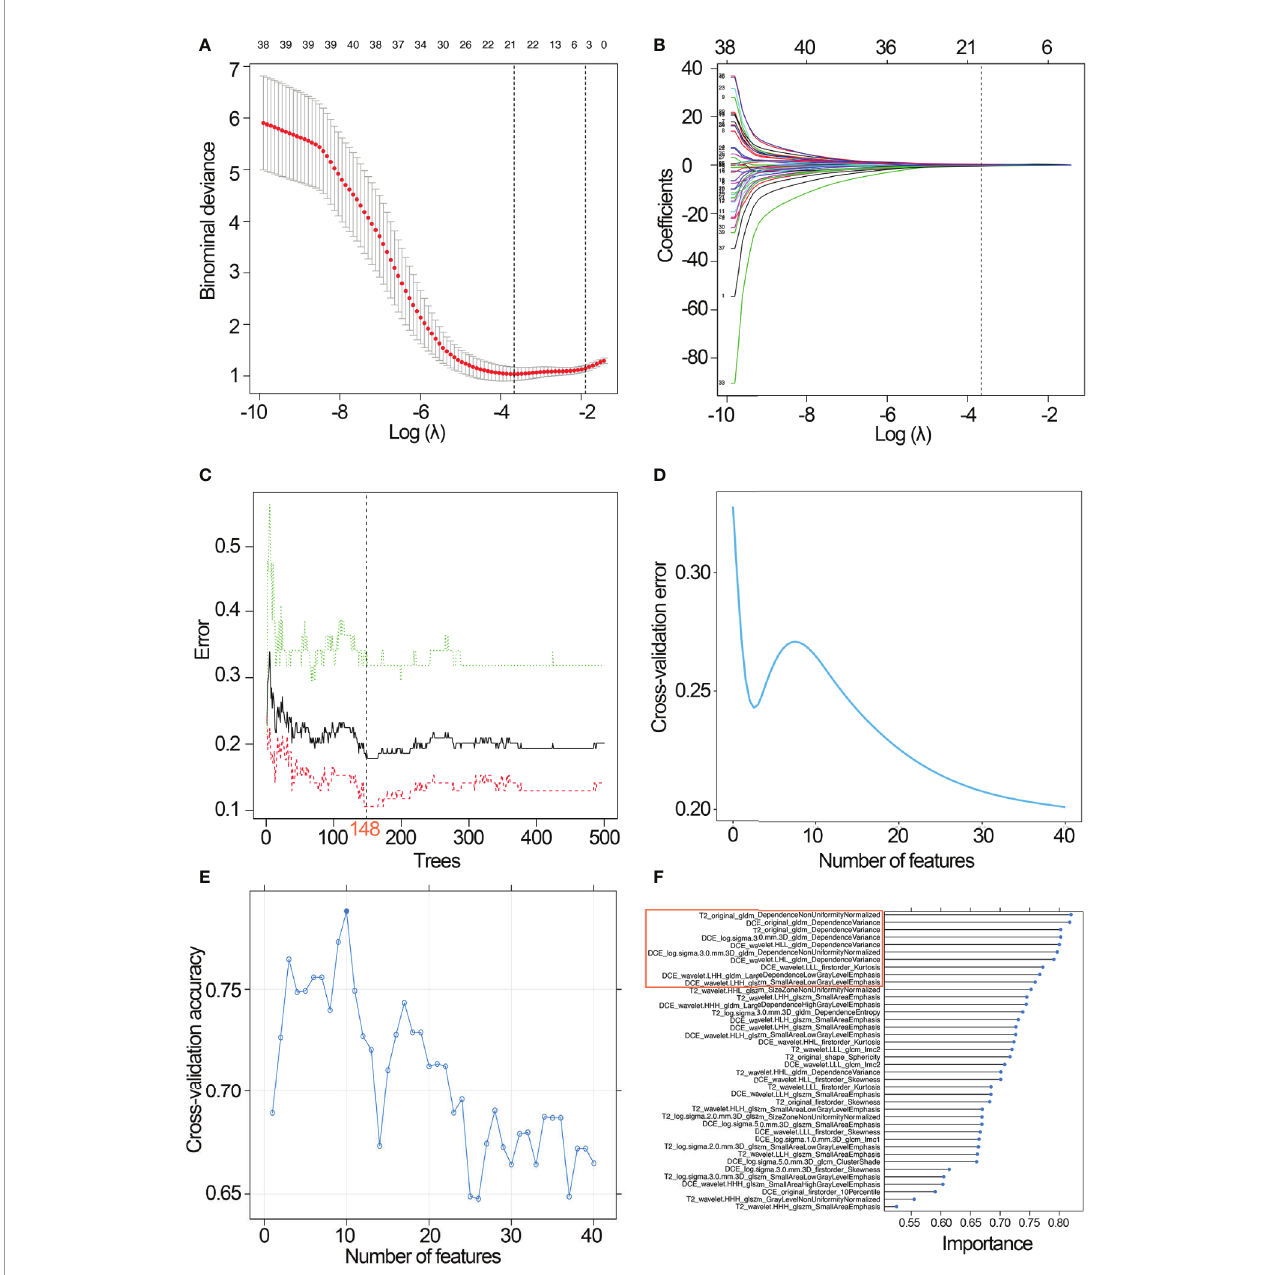
FIGURE 3 | Development of the three classi fi ers. (A) Selection of the tuning parameter l in the LASSO classi fi er via 10-fold cross-validation based on minimum criteria. (B) LASSO coef fi cient pro fi les of the 21 radiomics features. A vertical line was drawn at the selected value, where the optimal l resulted in eight non-zero coef fi cients. (C) Selection of the optimal number of growing trees (ntree=148) with the lowest discriminative error in the RF classi fi er. (D) Feature selection process using RFS-FS and 10-fold cross-validation in the training set: 40 features with the lowest discriminative error were selected for predictive classi fi er development. (E) Feature selection process using SVM-RFE and 10-fold cross-validation in the training set: 10 features with the highest discriminative accuracy were selected for SVM classi fi er development; (F) SVM-RFE is used to rank features according to the feature importance, and the top 10 features were selected for SVM classi fi er development. LASSO, least absolute shrinkage and selection operator; RF, random forest; SVM, support vector machine; RFS-FS, RF-feature selection; SVM-RFE, SVM-based recursive feature